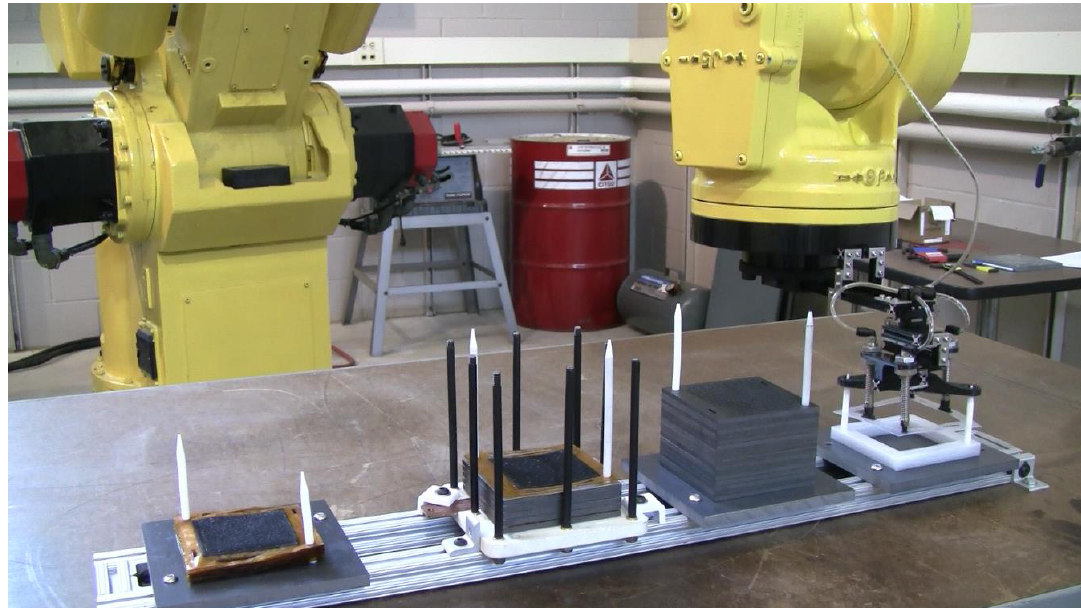
Figure 1. Fuel cell assembly line showing 50 cm 2 fuel cell components that have been inserted in presenters prior to the assembly process [41]. In this image a Fanuc robot picks a gasket from the presenter to insert it in the fuel cell stack (second stack from left) .